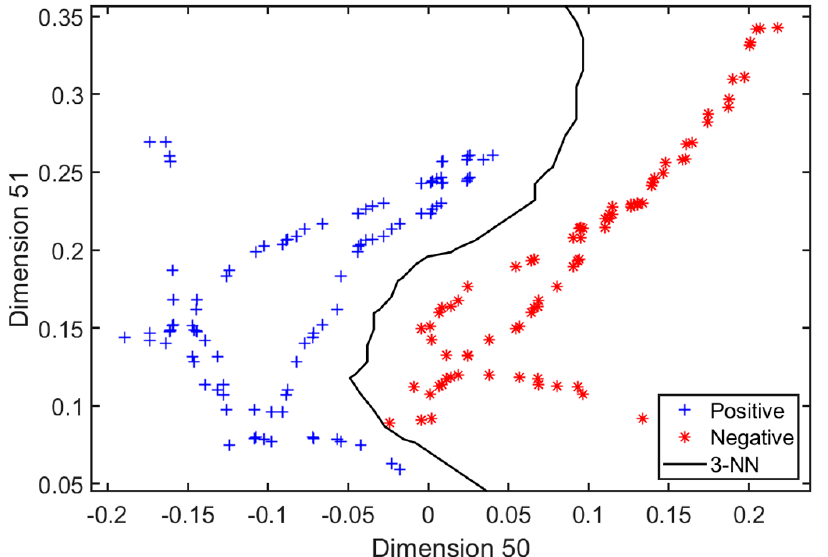
Figure 5. The resulting re-engineered embeddings of the samples from IMDB Dataset. Compared with Figure 3, the distribution is found to be much less overlapping. As an example, using a 3-NN classifier can divide the two categories directly. Table 1. Results comparison using the IMDB Dataset. The initial classification results using naïve Bayes classifier, as well as the results after applying the re-engineering mechanism. These results are averaged from 100 random tests. The boost of the performance has been found substantial. Metric Naïve Bayes Re-Engineering Precision 81.29% 97.50% Recall 70.10% 97.50% F 1 -score 75.28%